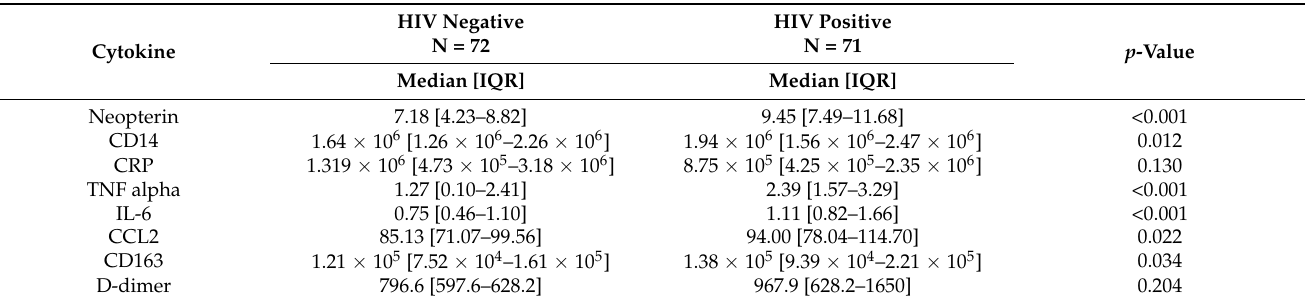
Table 5. Patient plasma cytokine levels.